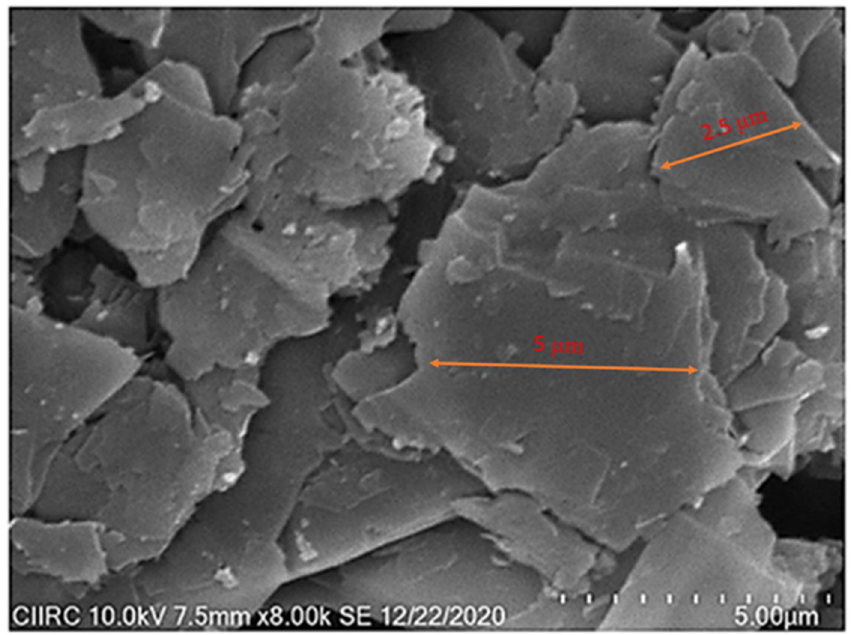
Figure 2. SEM image of